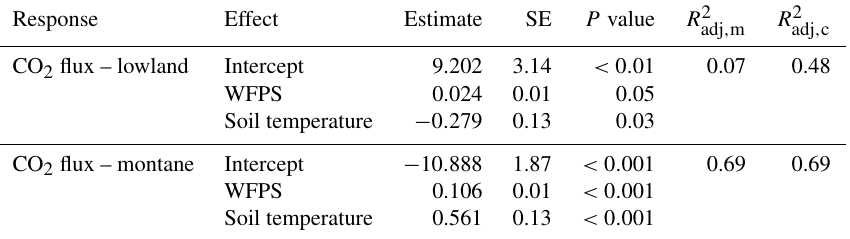
Figure 2. (a) Mean weekly air (solid line) and soil temperature at 20cm depth (dashed line) in the lowland (dark green) and montane (light green) forest sites. (b) Yearly median air and soil temperatures. (c) Mean weekly water-filled pore space (WFPS) [%] in the lowland and montane forest soils at 30cm depth. (d) Median WFPS in the lowland and montane forest. (e) Weekly median soil CO 2 fluxes ( F ) with error bars indicating the standard deviation. Green horizontal bars on top of (c) indicate the dry seasons in the lowland and in the montane forests, respectively. (f) Median soil CO 2 fluxes in the lowland and montane forests. Table 1. Fixed effect estimates for CO 2 fluxes in the lowland and montane forests, including water-filled pore space (WFPS in %) and soil temperature (in ◦ C) as predictors for the soil CO 2 efflux (in µmolm − 2 s − 1 ). For each effect, estimated standard error and estimated P values are given, along with the estimated marginal (m) and conditional (c) R 2 (Nakagawa and Schielzeth, adj